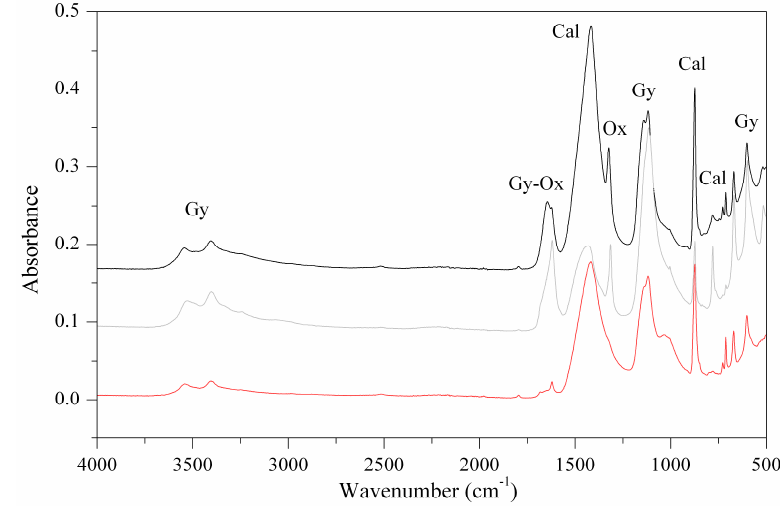
Figure 5. Representative FTIR spectra of some samples showing superficial alteration forms.